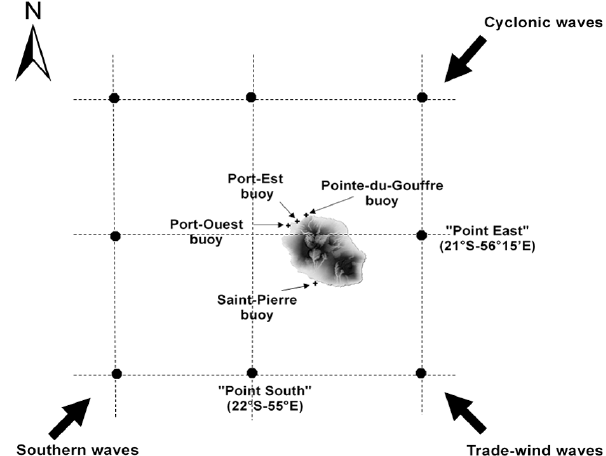
Fig. 1. The pilot site and positions of the wave gauges and the NWW3 points used in the study. The arrows indicate the sources of the dominant wave